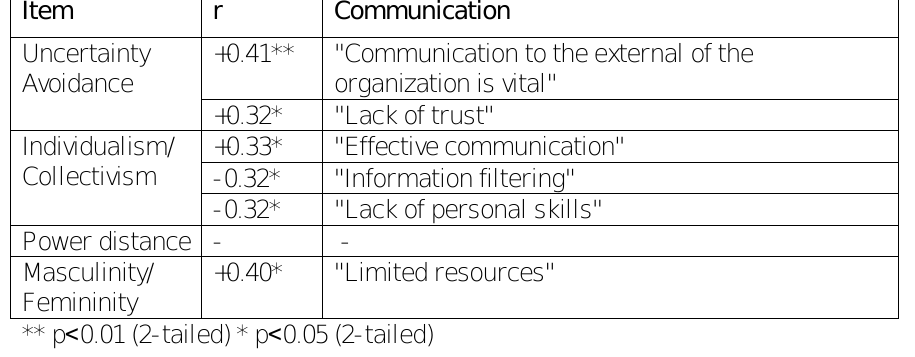
Table 2: Correlations between National Cultures and Communication variables Item r Communication +0.41** organization is